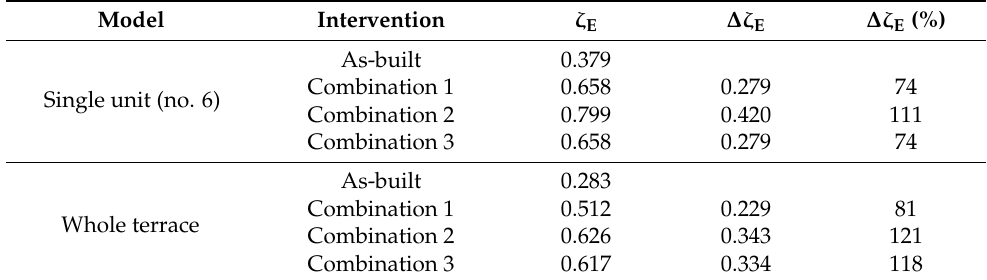
Table 6. Comparison of the performance ratio ζ E between single-unit and whole-terrace models at SD limit state.